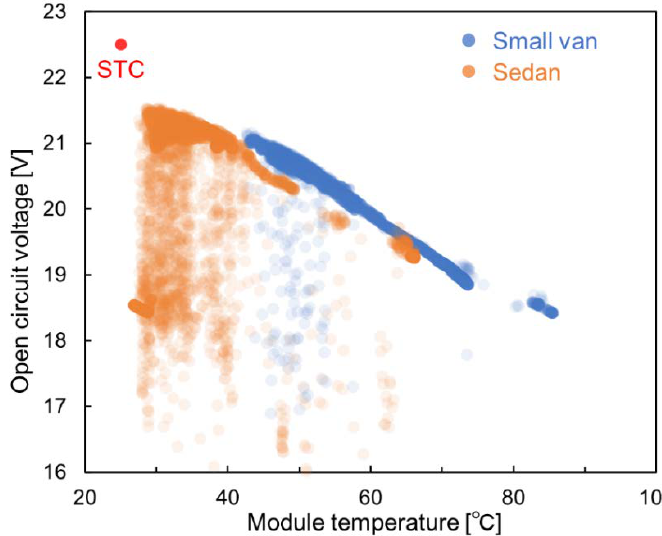
Figure 11. Relationship between the open circuit voltage of the VIPV module and the average temperature of the module averaged over T1, T3, and T5. The value under standard test conditions (STC) is also plotted.